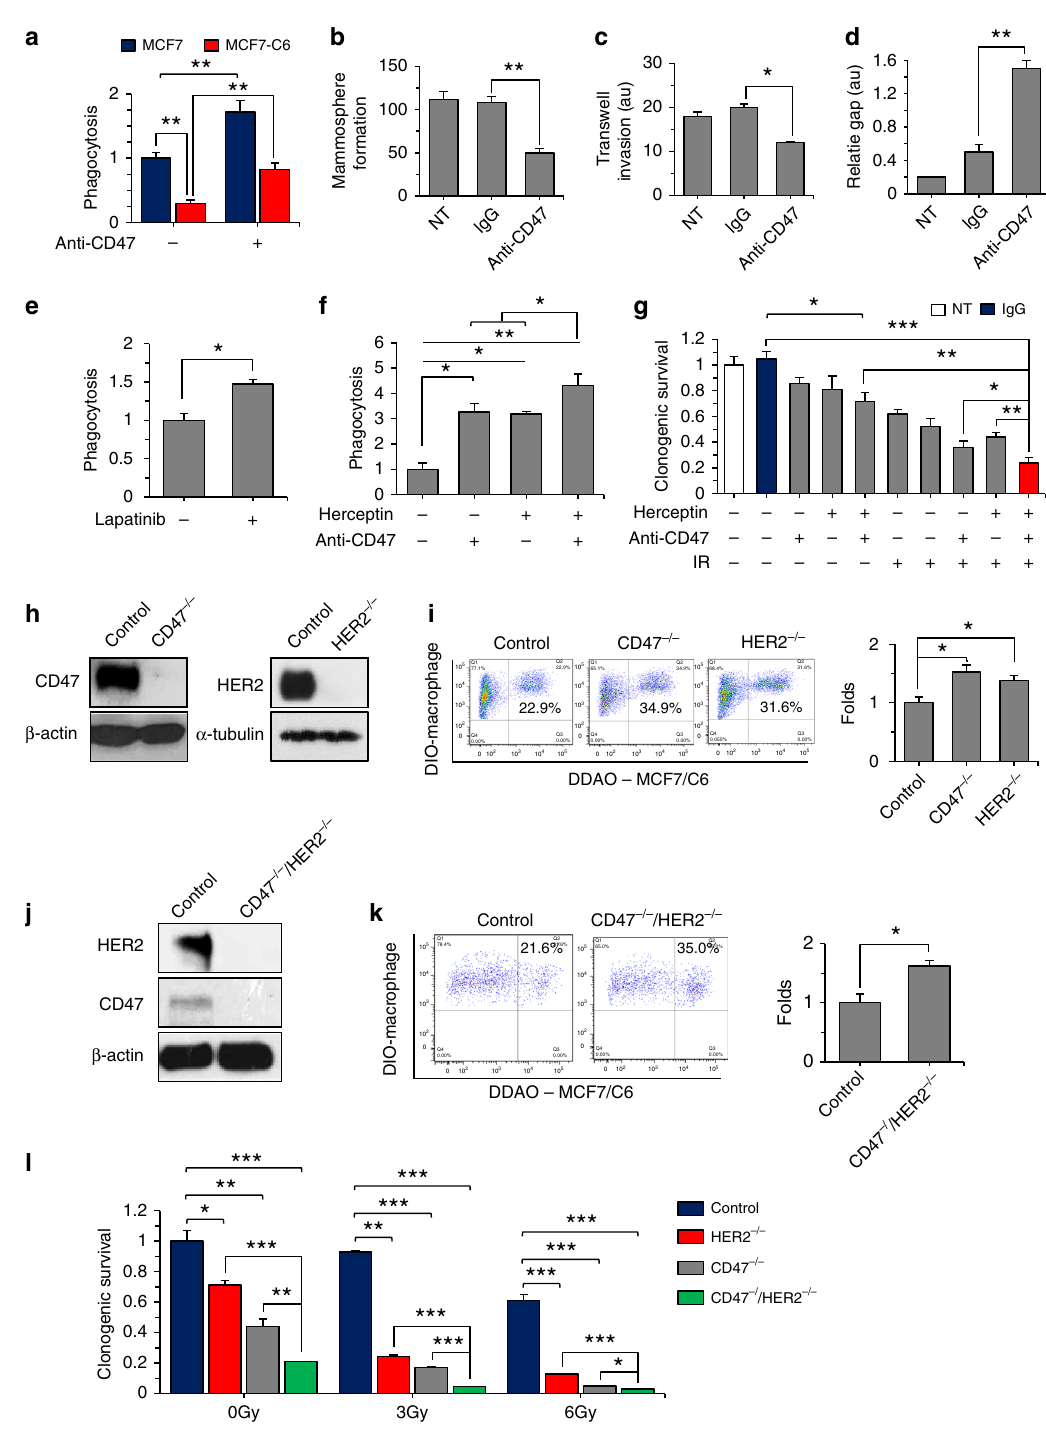
solid BC. The aggressive growth features including mammo- sphere formation (Fig. 4b and Supplementary Fig. 5c), matrigel invasion (Fig. 4c and Supplementary Fig. 5d), and gap- fi lling capabilities (Fig. 4d and Supplementary Fig. 5e) were con- siderably suppressed by treatment with the anti-CD47